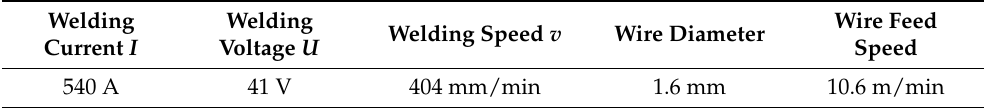
Table 1. Main welding